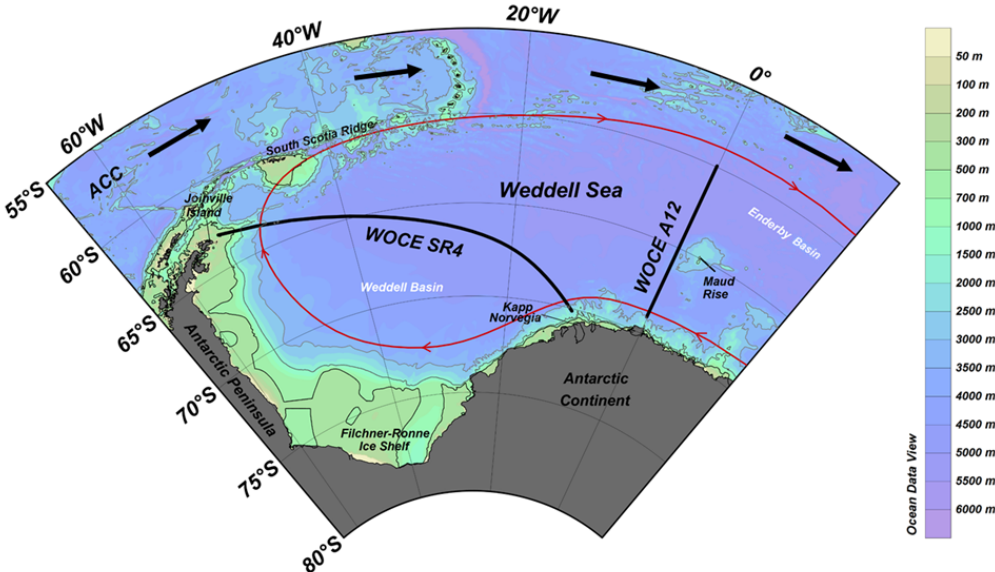
Figure 1. Schematic locations of the hydrographic sections. WOCE A12 is found along the Greenwich Meridian, and WOCE SR4 lies between Joinville Island and Kapp Norvegia. The arrows indicate the direction of the Antarctic Circumpolar Current (ACC; black) and the Weddell Gyre (red) flows. The thin black and gray lines represent the 500, 1500, and 3000m isobaths.